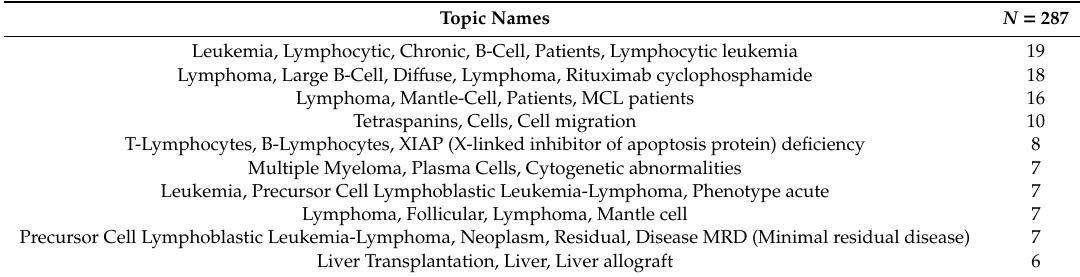
Figure 12. Network of the relationship between publications that are cited in patents in the field of medicine according to the subcategories of medicine of the ASJC. Table 7. Leukemia. Cluster (14), weigh 9.92%.